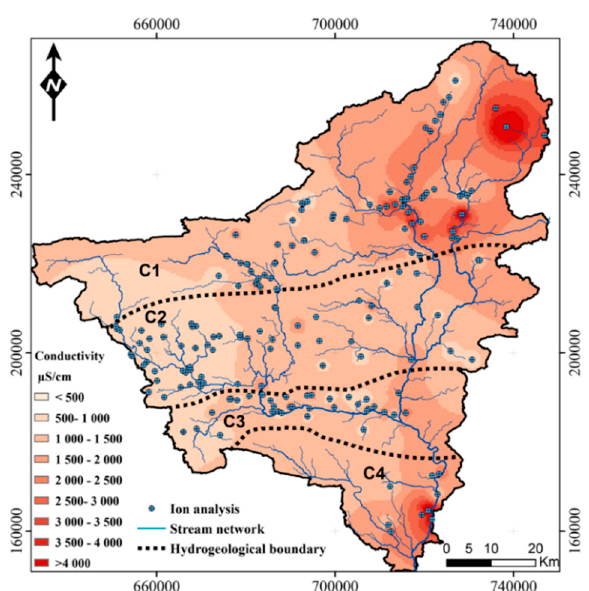
Figure 11. Map of electrical conductivity in the Jurassic–Cretaceous aquifer of Eastern Upper